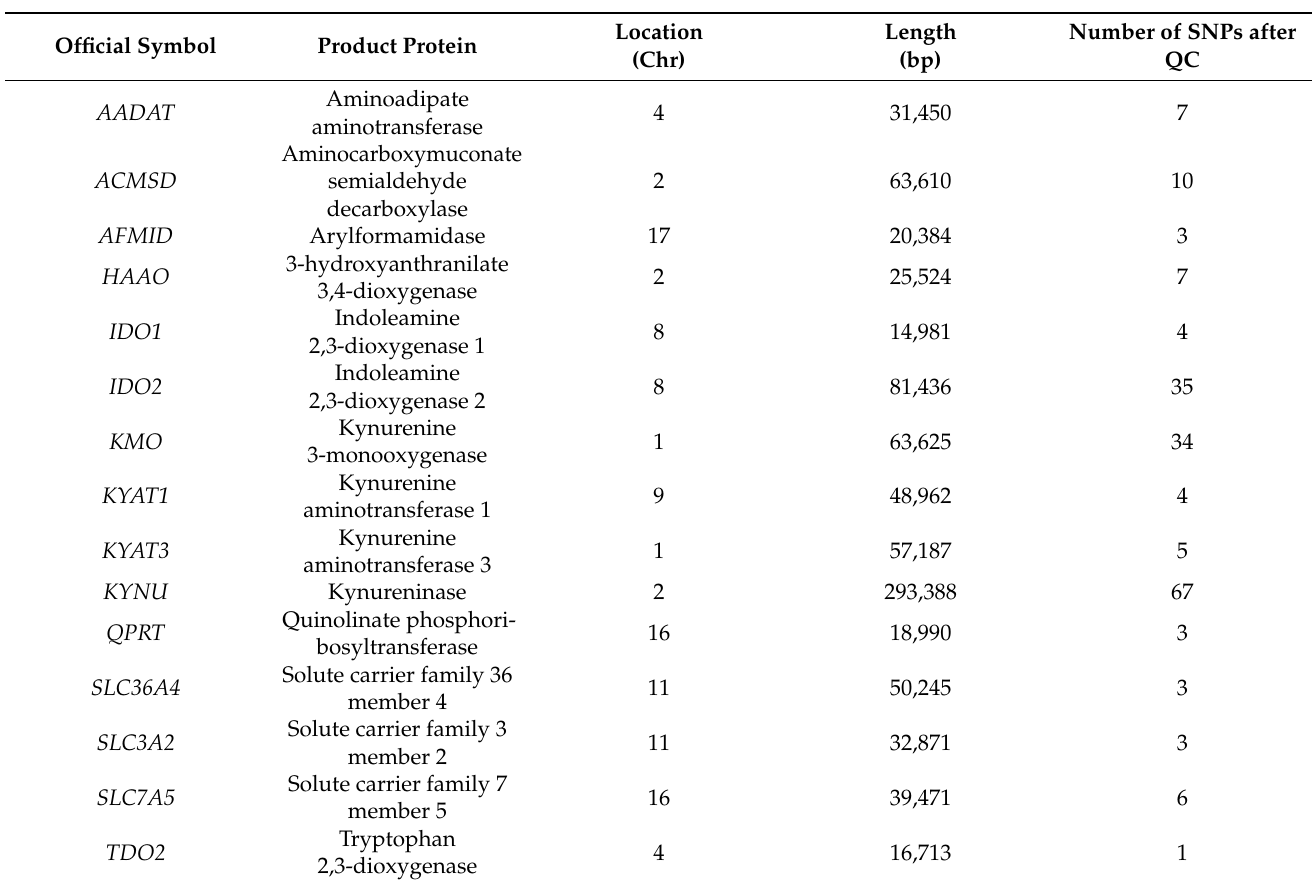
Table 1. Candidate gene information.